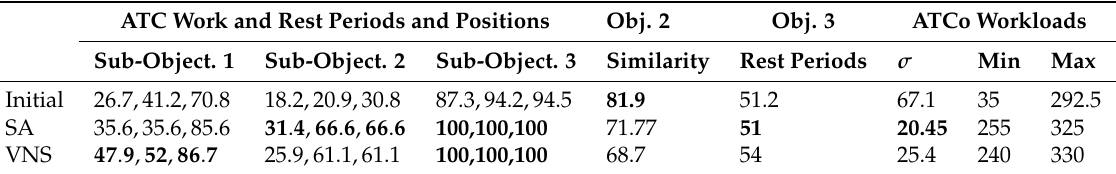
Table 4. Objective functions in the initial solution and solutions reached by SA and VNS for Instance 2. ATC Work and Rest Periods and Positions Obj. 2 Obj. 3 Sub-Object. 1